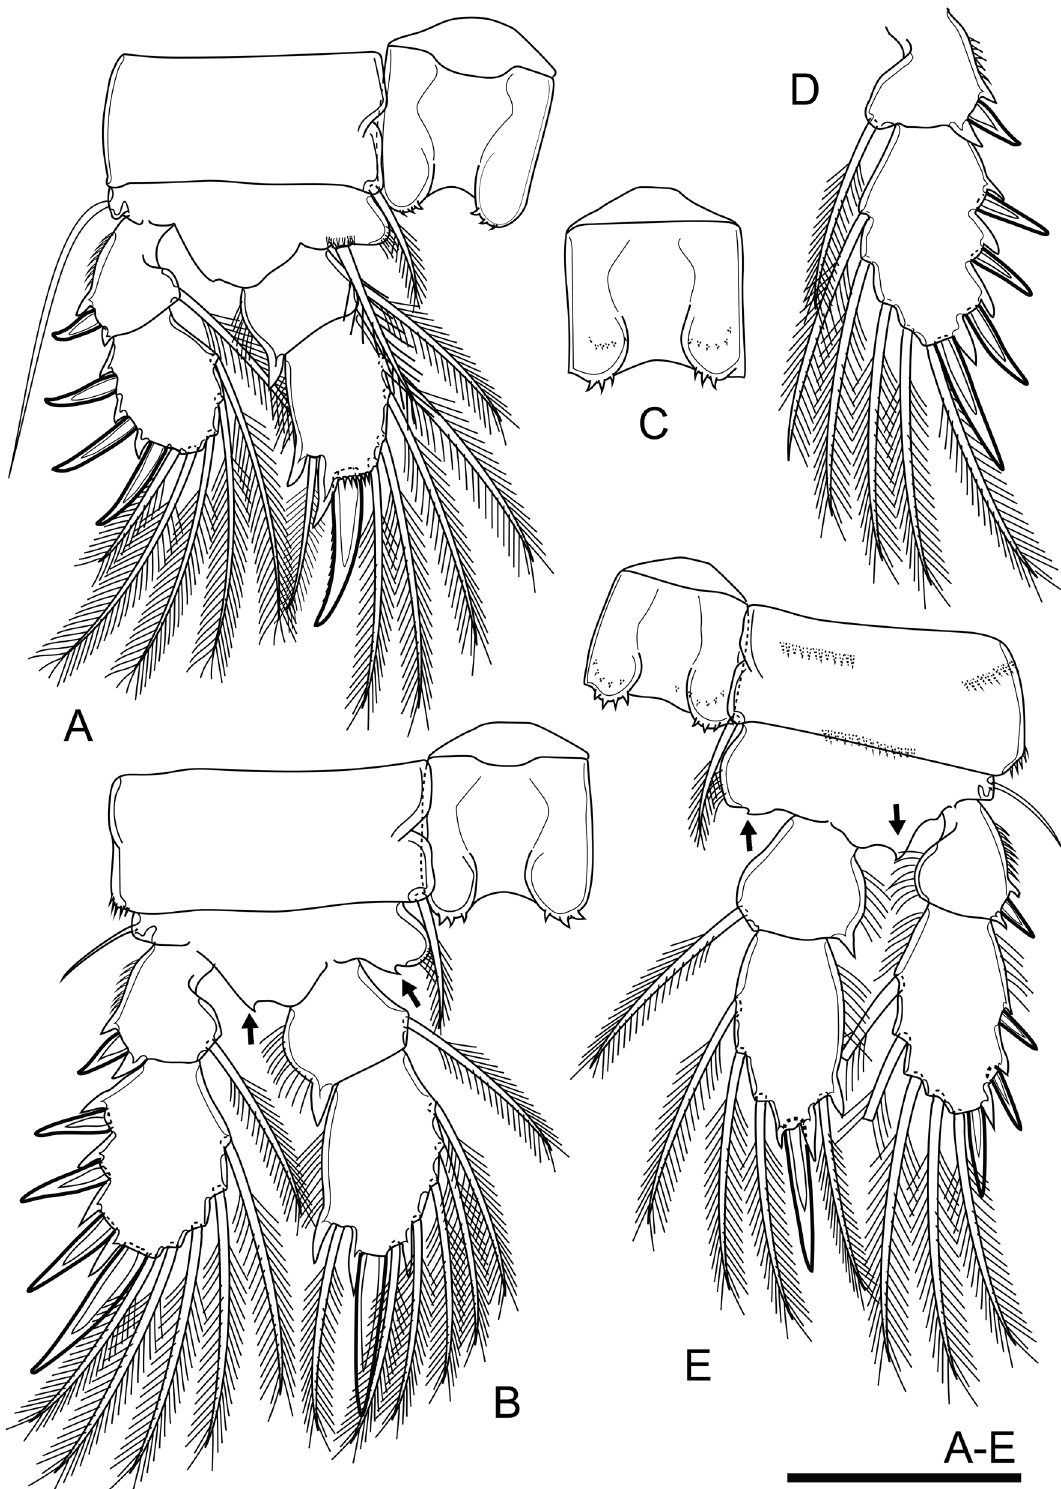
Fig. 7. Metacyclops sakaeratensis sp. nov., holotype, ♀ (ZMB 34230 slide No. 5120). A . P1, frontal view. B . P2, frontal view. C . Frontal view of intercoxal sclerite of P3. D . P3 exp-1. E . P4, frontal view. Arrows indicate hook-like expansion. In C and E, the spinule row is on the caudal surface of intercoxal sclerite and coxa. Scale bar = 50